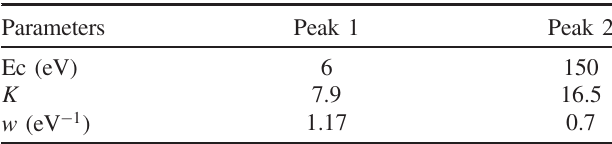
TABLE I. Values of the parameters obtained from the fit to the experimental electron energy spectrum.